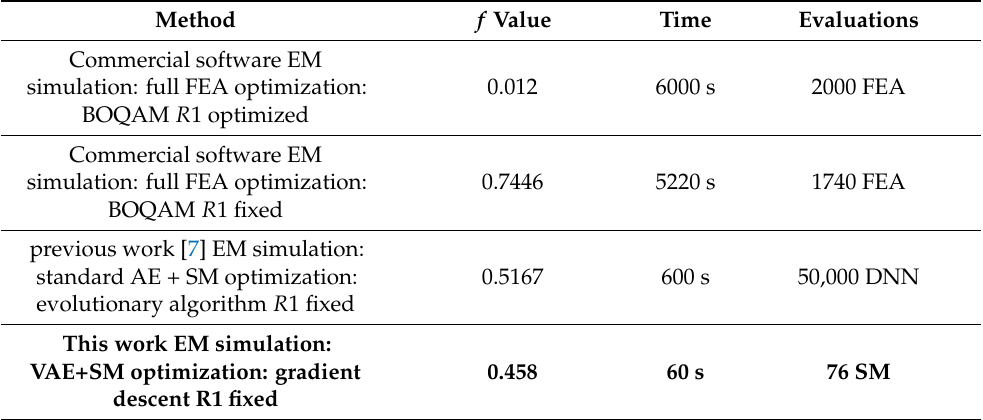
Table 5. Average optimization performance over 50 runs and comparison with other